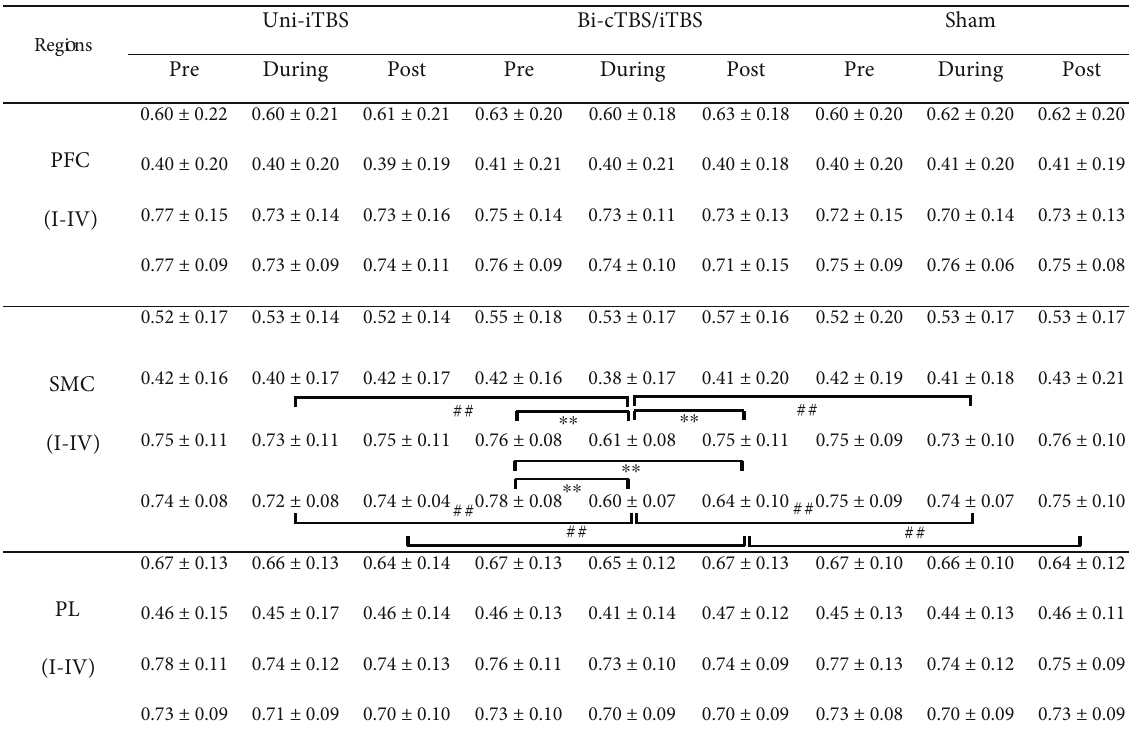
Figure 7: WPCOs in di ff erent cortical regions under three HD-TBS protocols. Data: untransformed WPCO mean ± SEM ; bands I – IV: 0.7 – 2.0Hz, 0.15 – 0.7Hz, 0.06 – 0.15Hz, and 0.02 – 0.06Hz, respectively. ∗ p ≤ 0 : 05 and ∗∗ p ≤ 0 : 01 for signi fi cance among three phases. # p ≤ 0 : 05 and ## p ≤ 0 : 01 for signi fi cance among three HD-TBS